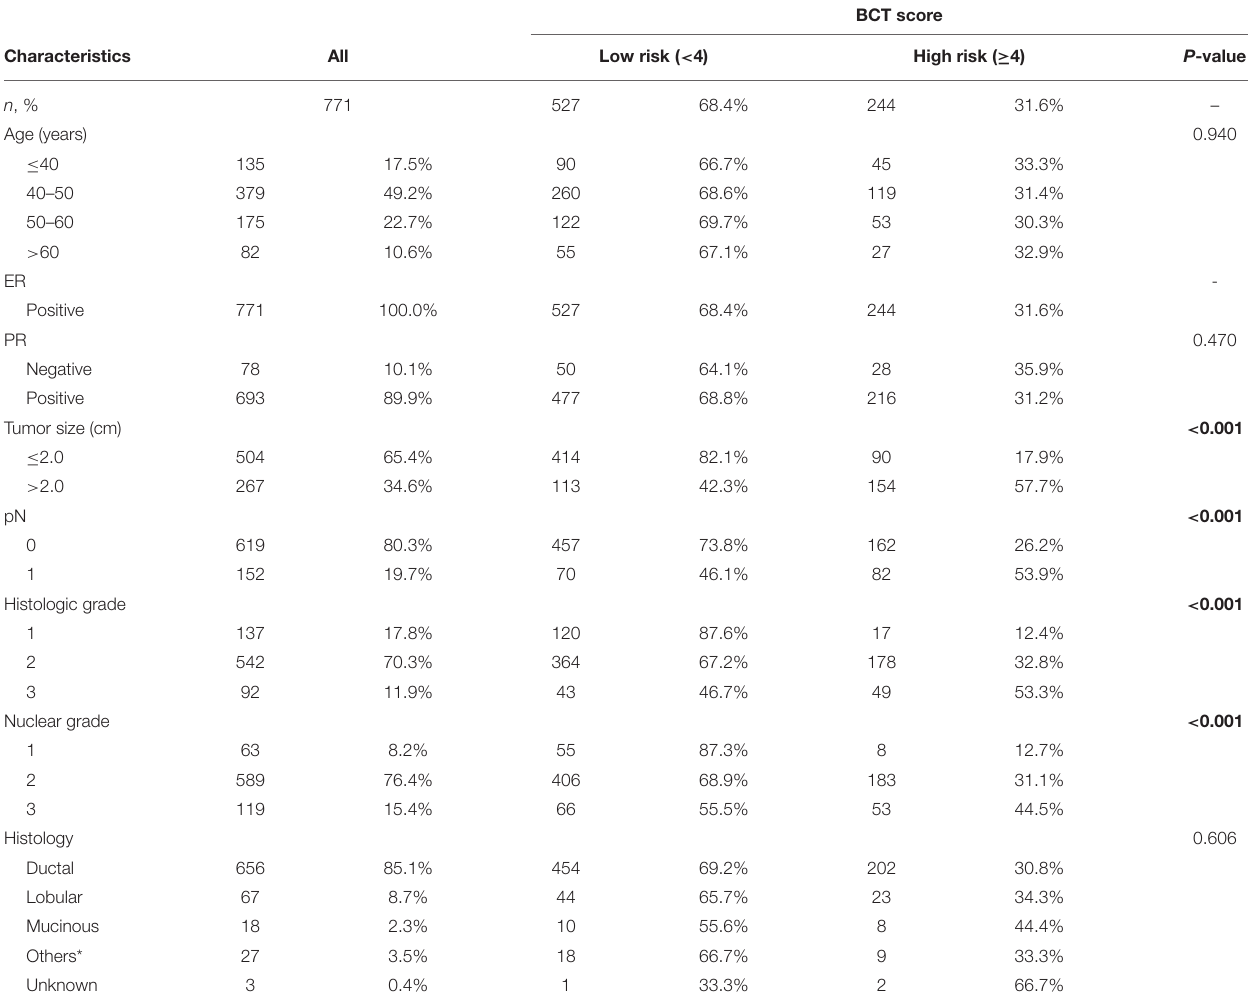
TABLE 1 | Clinical characteristics of the risk groups according to the BCT